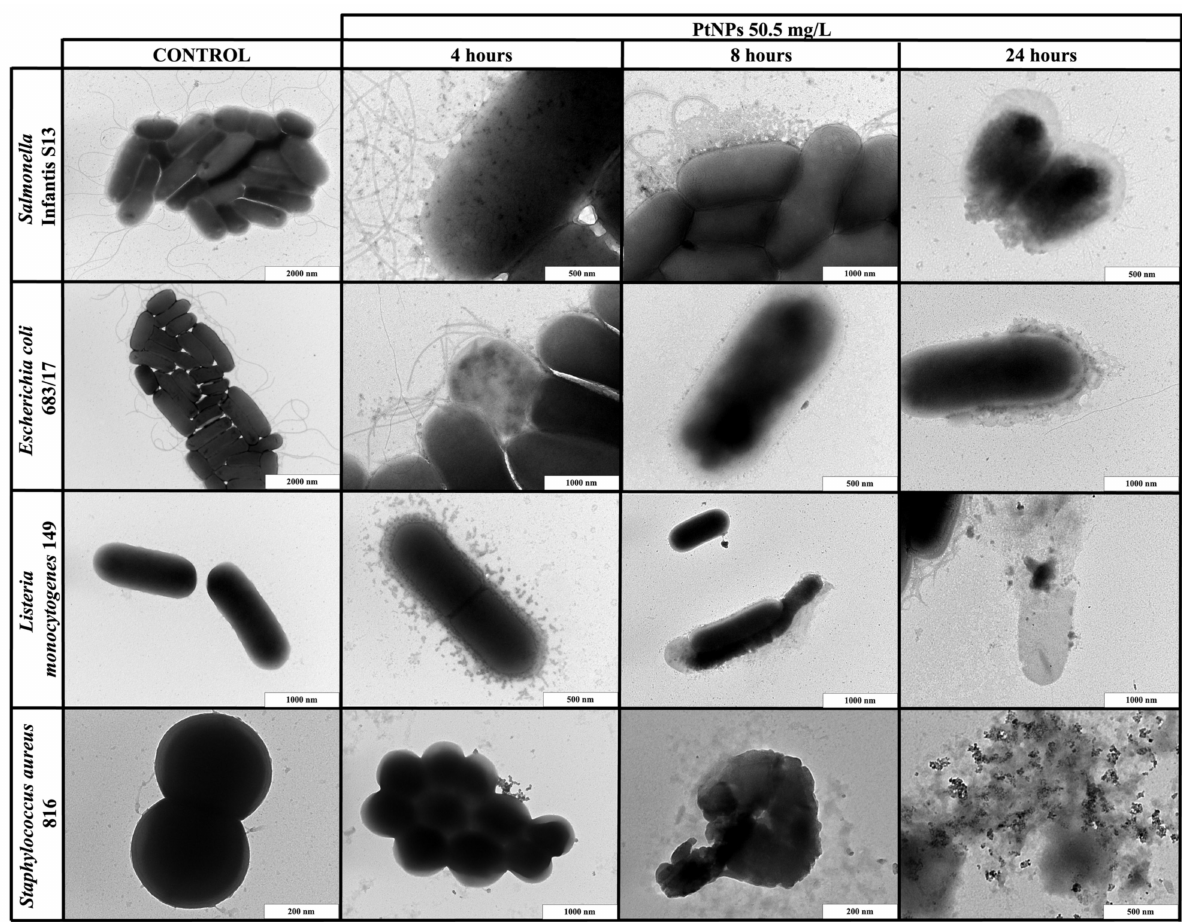
Figure 3. TEM visualization of the interactions between platinum nanoparticles (PtNPs) and planktonic cells of S. Infantis S13, E. coli 683/17, L. monocytogenes 149 and S. aureus 816 after 4, 8 and 24 h exposure.